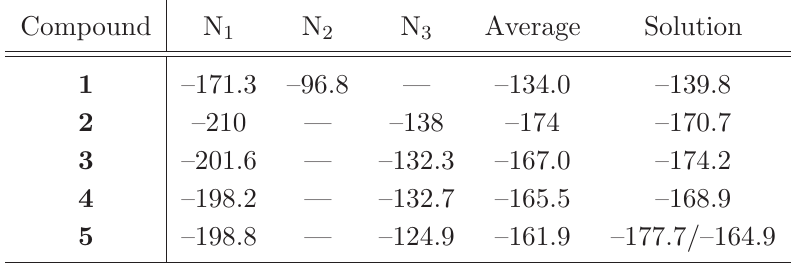
Table 4 15 N NMR chemical shifts (ppm) for azoles 1 - 5 in the solid state